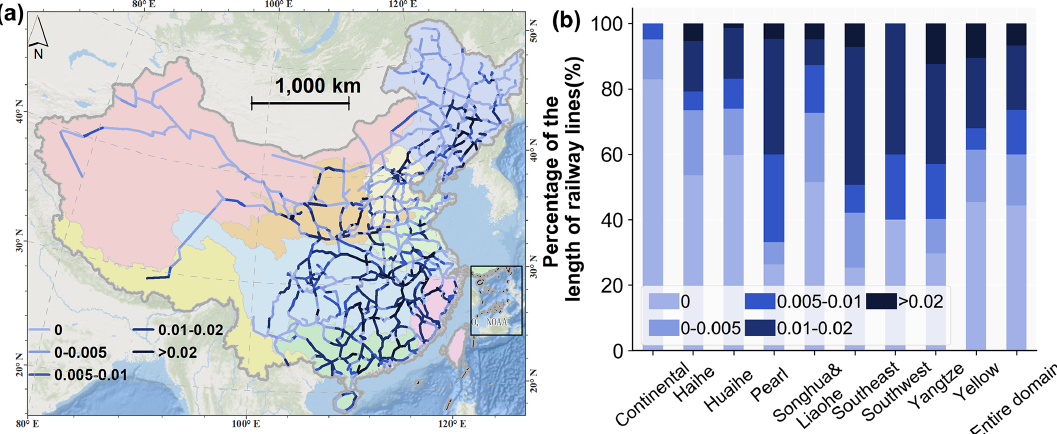
Figure 4. (a) Annual failure probability map of the network segments affected by floods and (b) the percentage of the length of railway lines for different failure probability categories per river basin. Railway geometries © OpenStreetMap contributors 2019. Distributed under the Open Data Commons Open Database License (ODbL) v1.0.